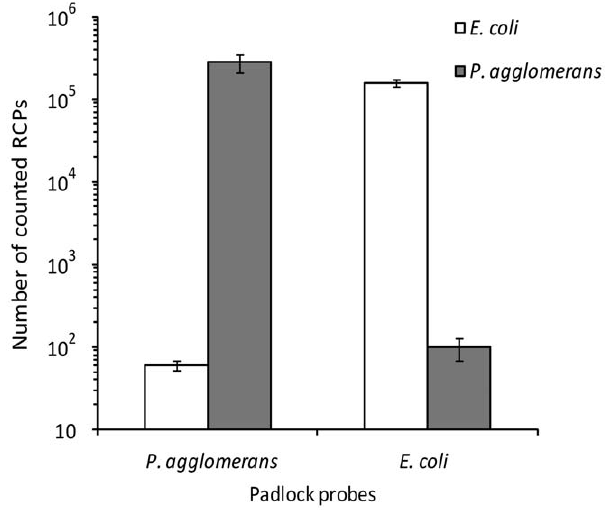
Figure 5. Discrimination of EC and PA bacteria based on a single nucleotide difference in the target DNA sequence in two samples containing either 1 ng EC genome or PA genome (approximately 300 000 copies), assayed with probes specific for EC and PA genomes in duplex reactions. Error bars, 6 1 s.d.; n=2.